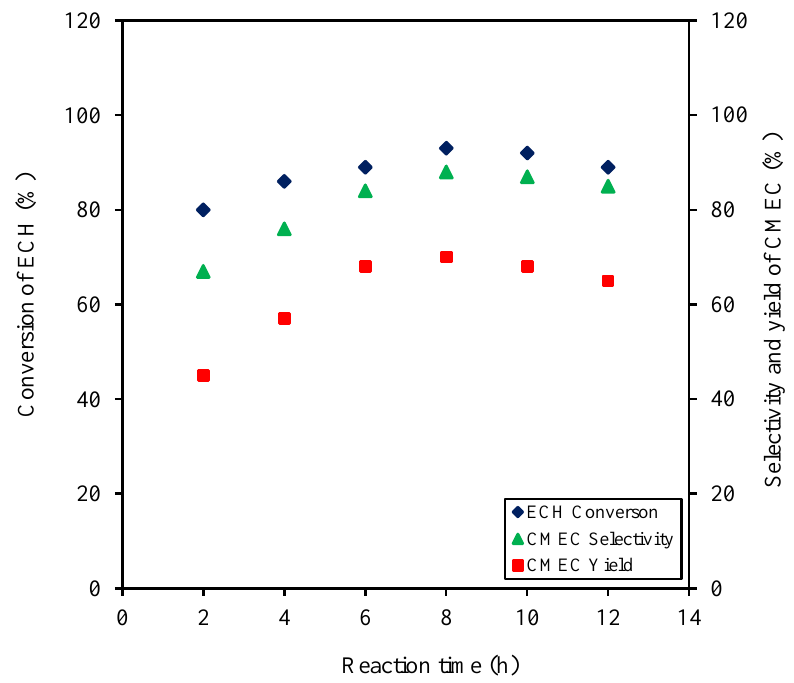
Figure 15. Time dependence on conversion of ECH versus selectivity and yield of CMEC. Experimental conditions: catalyst Zr / ZIF-8; catalyst loading 10% ( w / w ); reaction temperature 353 K; CO 2 pressure 8 bar; stirring speed 350 rpm.